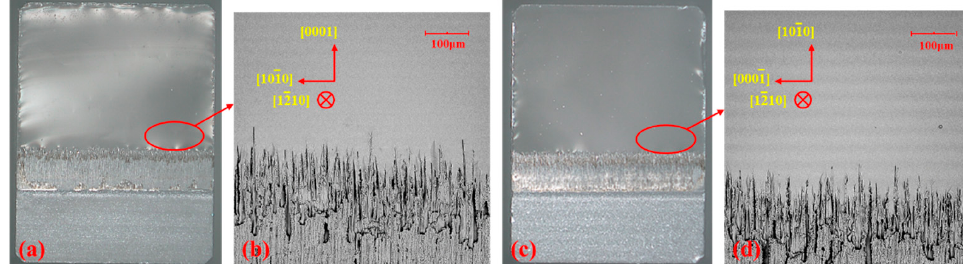
Figure 10. Morphology of the fractured surface in A-plane sapphire tests. ( a ) Fractured surface of A-C tests, “A” is the cross-section of the sapphire sample, “C” is the loaded surfaces. ( b ) Local cracks. ( c ) Fractured surface of A-M tests, “A” is the cross-section of the sapphire sample, “M” is the loaded surfaces. ( d ) Local cracks.